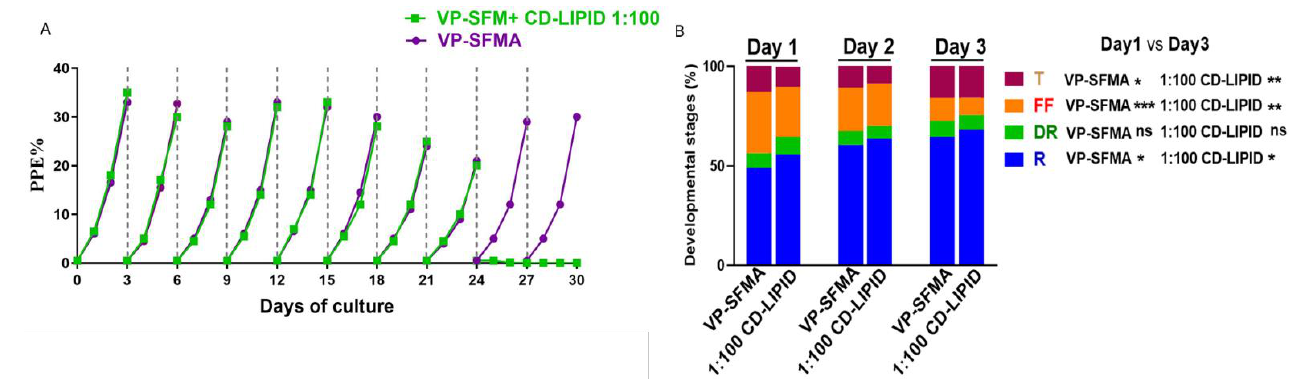
Figure 3. VP-SFMA supports long-term continuous in vitro culture of B. duncani . ( A ) Comparison of the growth curve of B. duncani proliferation using VP-SFMA and VP-SFM +CD LIPID (1:100) medium over a 30-day period with 9 splittings. Mean values from three separate experiments using triplicate wells for each tested condition were represented. PPE: percentage of parasitized erythro- cytes. Dotted lines indicate subculturing performed every 3 days and adjusted back to 0.5%. ( B ) Percentages of different parasite development stages in VP-SFMA and 1:100 dilution of CD Lipid mixture. R, ring; DR, double rings; FF, filamentous, T, tetrads. ns: p > 0.05, *: p < 0.05, **: p < 0.01, ***: p < 0.001.